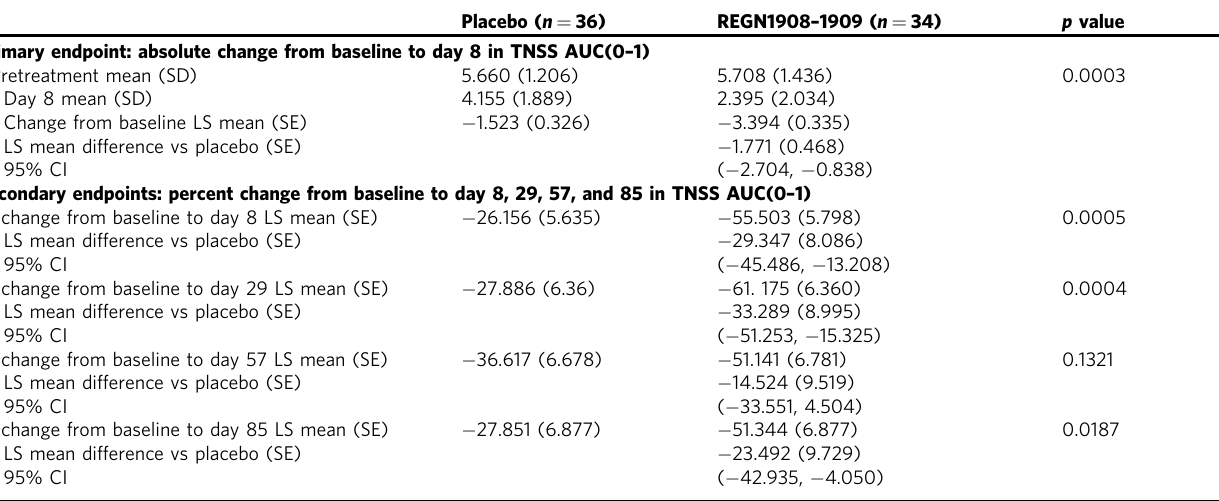
Analyses are based on ANCOVA model with treatment group as a factor and baseline as a covariate. For secondary ef fi cacy endpoints no control for multiplicity was performed; therefore, p values are considered nominal. Absolute change in TNSS from baseline to days 29, 57, and 85 shown in Supplementary Table